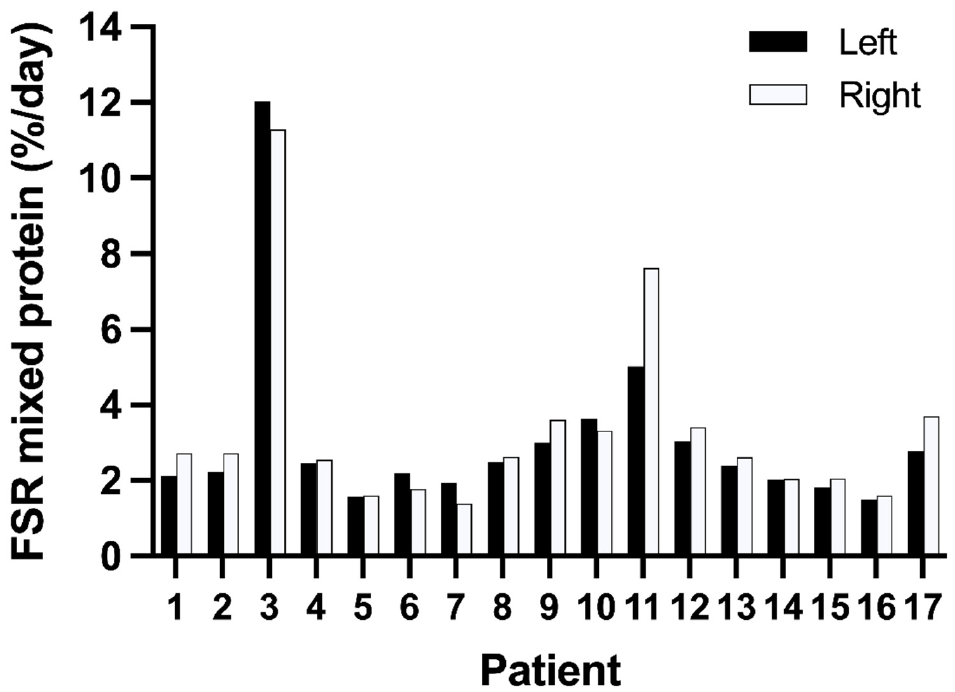
Figure 1. Fractional synthesis rates (FSRs) in skeletal muscle mixed protein ( top ) and mitochondrial protein ( bottom ) of both legs of critically ill patients ( n = 17). Individual values are given where open bars represent the left leg and filled bars represent the right leg. Mean values of mitochondrial FSR have been published previously [15].